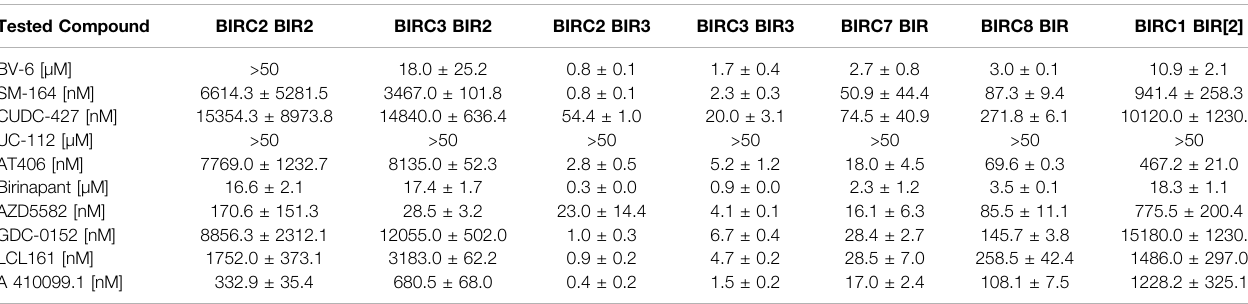
TABLE 3 | Compound EC 50 s ± SEM in the cellular target engagement NanoBRET assay. Tested